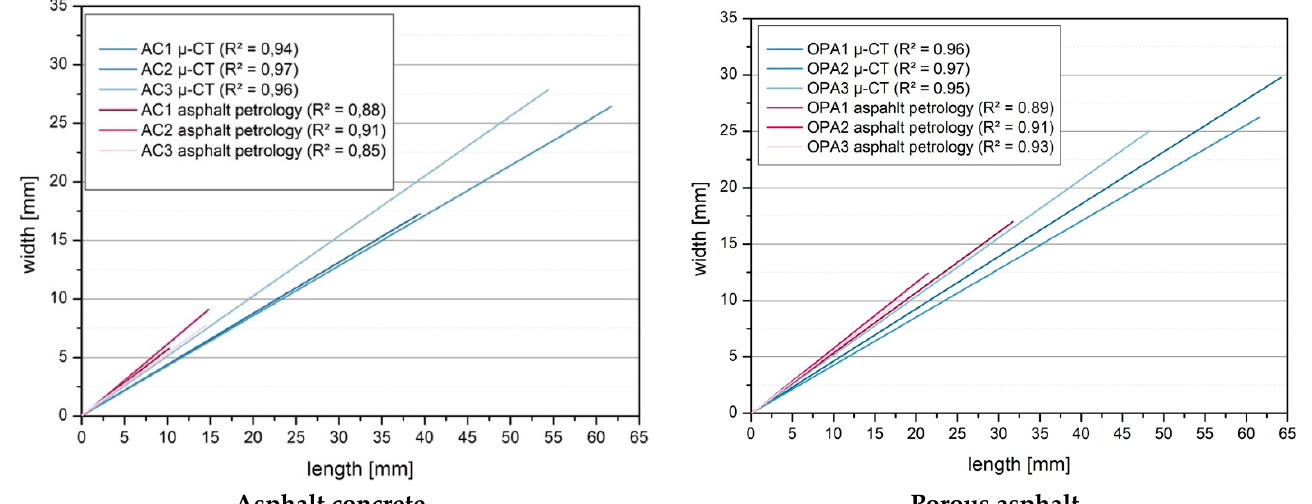
Figure 12. Comparison between length and width (2D method (asphalt petrology) and 3D method ( µ -CT)).